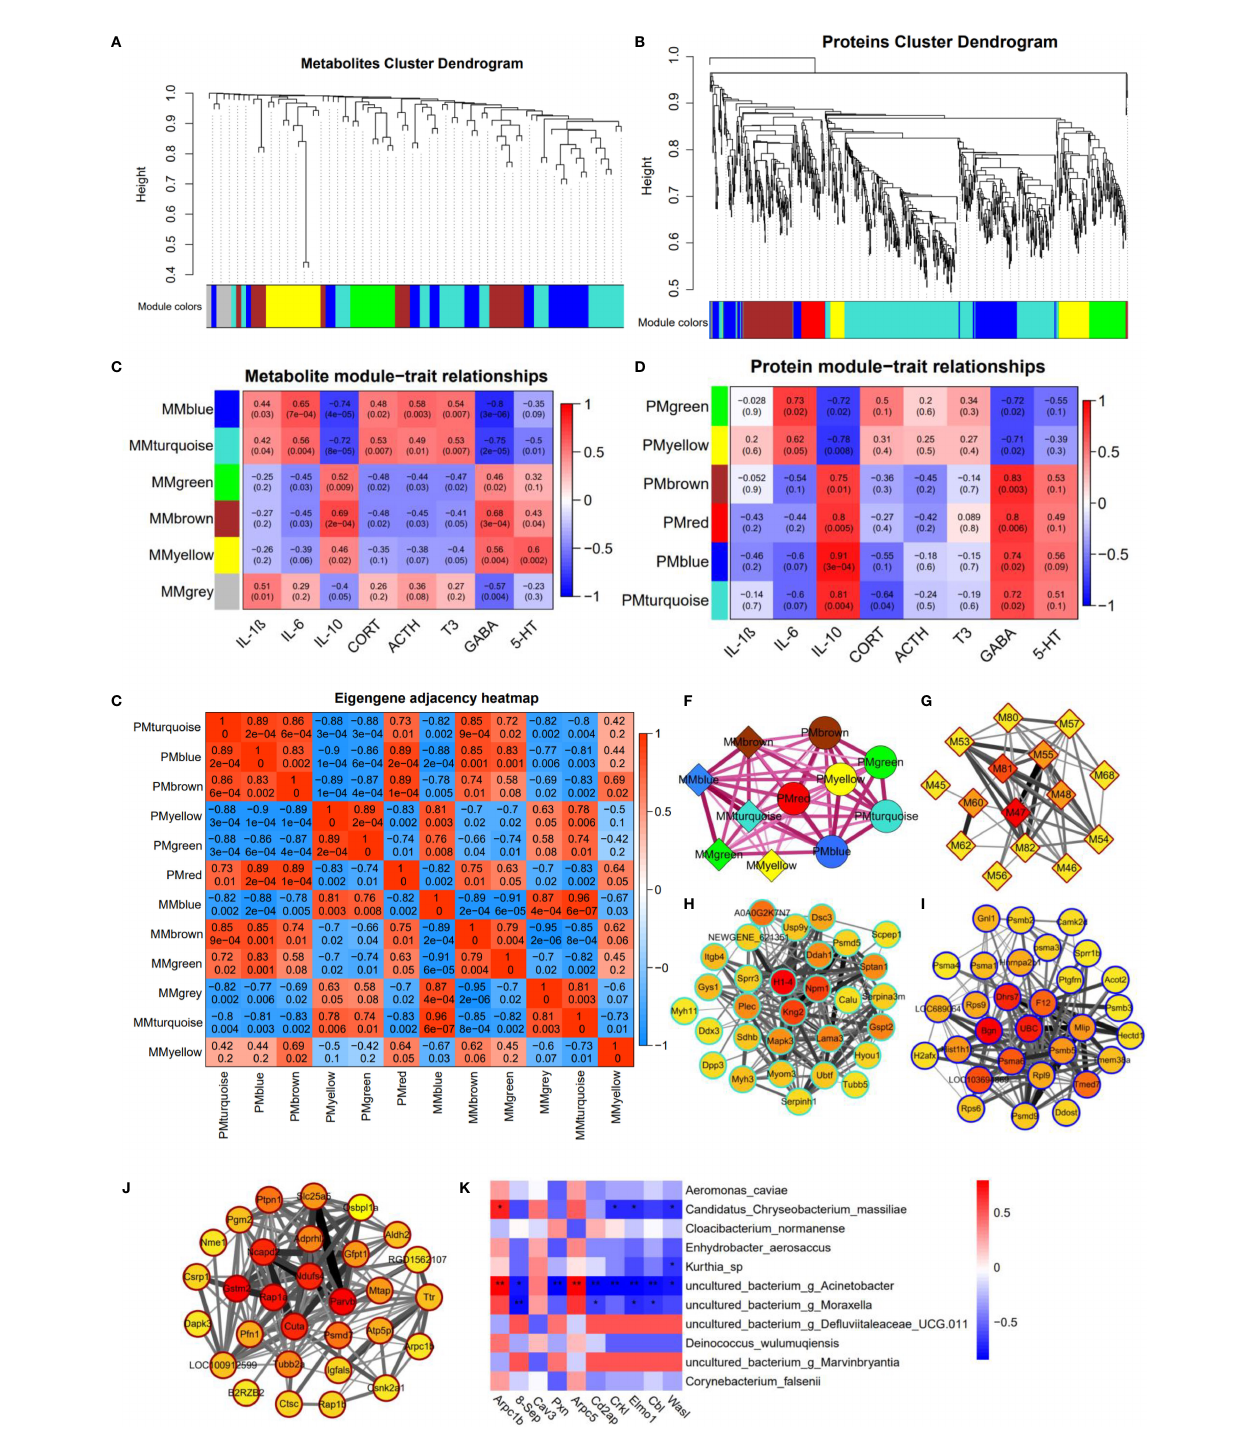
FIGURE 8 | Multi-omics integration analysis through WGCNA. (A) Clustering dendrograms based on (A) metabolomic data and (B) proteomic data. Heatmap of the correlation between (C) metabolite and (D) protein module eigenvalues and biochemical traits. The correlations between protein modules and metabolite modules (E) , and are displayed as a network overlaid with adjacency values (F) . Network of (G) metabolites in MMbrown module, top 30 ranked proteins in (H) PMturquoise module, (I) PMblue module, and (J) PMbrown module; the color represents the MCC scores of the node with a gradient from yellow (low scores) to red (high scores). (K) The heat-map shows the Spearman correlation coef fi cients between proteins enriched in the bacterial invasion of epithelial cells pathway and oral bacteria (*P < 0.05; **P <